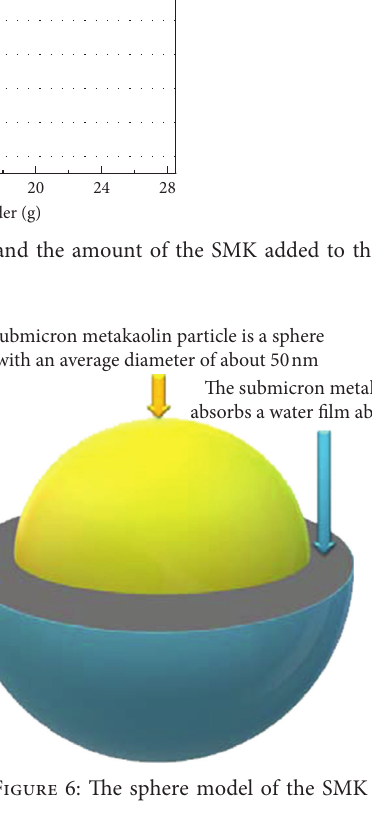
Figure 6: The sphere model of the SMK and